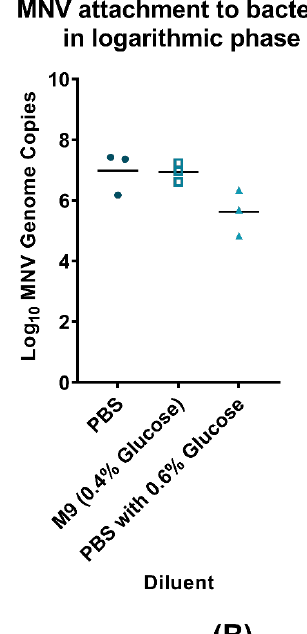
Figure 1. Impact of glucose and bacterial growth phase on MNV attachment to E. cloacae. MNV genome copies were measured using RT-qPCR after 1 h of viral attachment to E. cloacae in PBS, M9, or PBS-G media. The attachment was assessed using E. cloacae in ( A ) stationary and ( B ) mid-log growth phases. * designates an adjusted p -value of ≤0.05; n = 3.